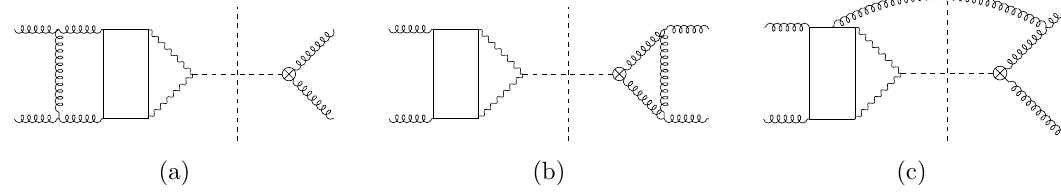
Figure 1. Representative Feynman diagram contributing to G (0) (cid:3) dashed line represents the interference between the two-loop light quark form factor on the left, and the top-loop form factor in HEFT on the right.